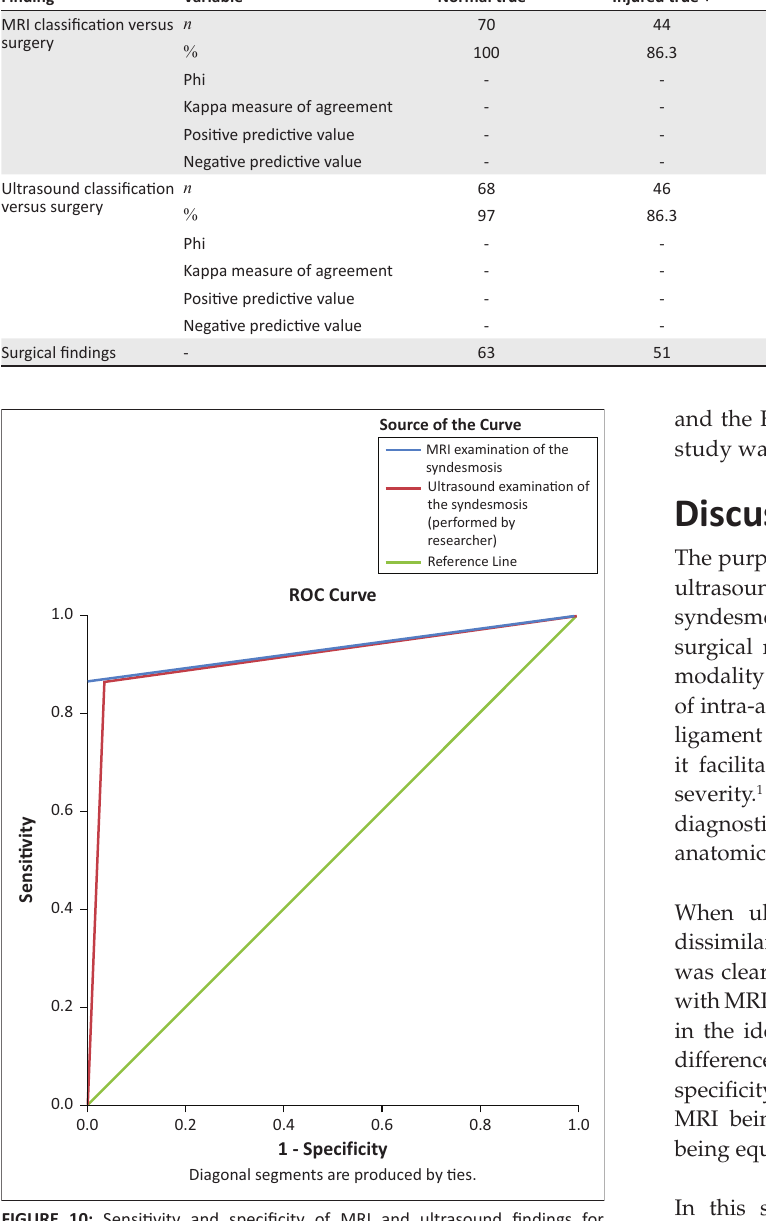
FIGURE 10: Sensitivity and specificity of MRI and ultrasound findings for syndesmosis injuries.